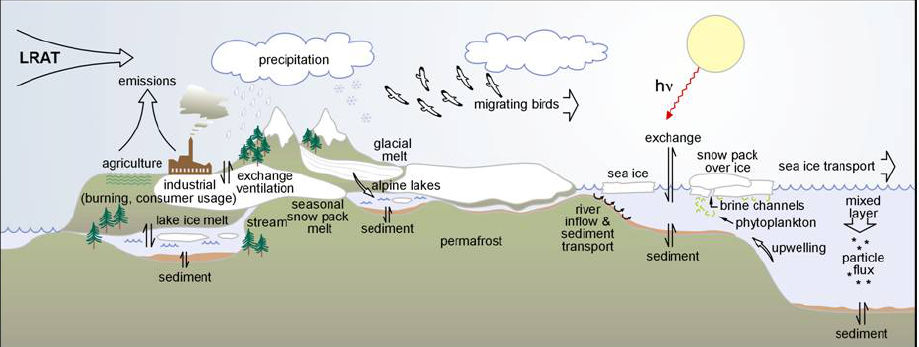
Fig. 1. Schematic diagram illustrating the various elements of and interactions occurring in the cryosphere that impact contaminant cycling and fate. LRAT (long-range atmospheric transport) is primarily responsible for the global distribution of contaminants, but the various exchanges represented here play important roles in cycling and redistribution of